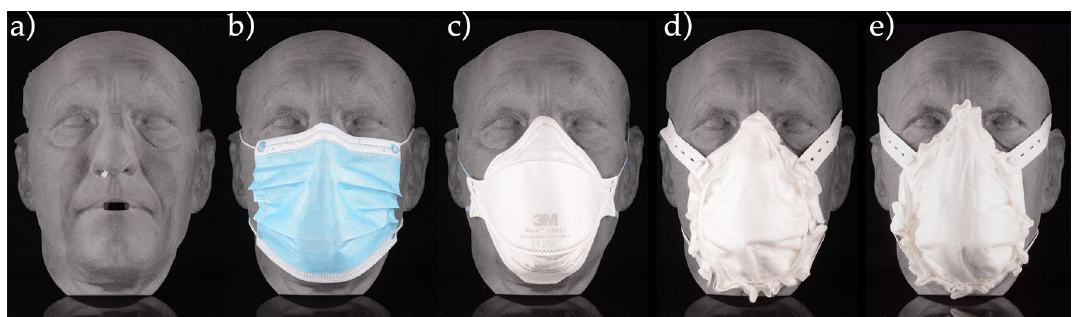
Figure 10. One of the twelve 3D-printed tests faces (a) with the air pressure sensor tube installed and (b) a surgical mask, (c) an FFP2 mask, (d) a statistically shaped mask, and (e) a personalized